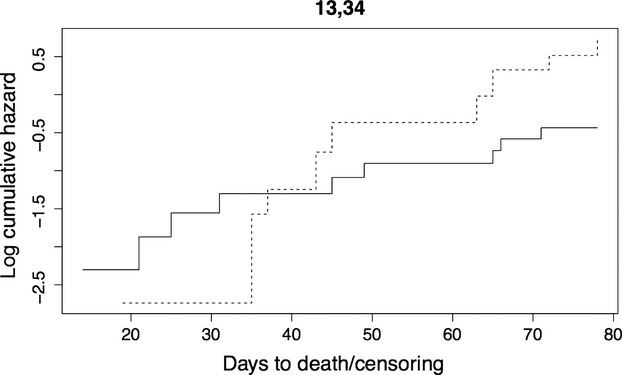
Hazard curves of females from line 13, 34 after experiencing homotypic (solid line) or heterotypic (dashed line) matings.